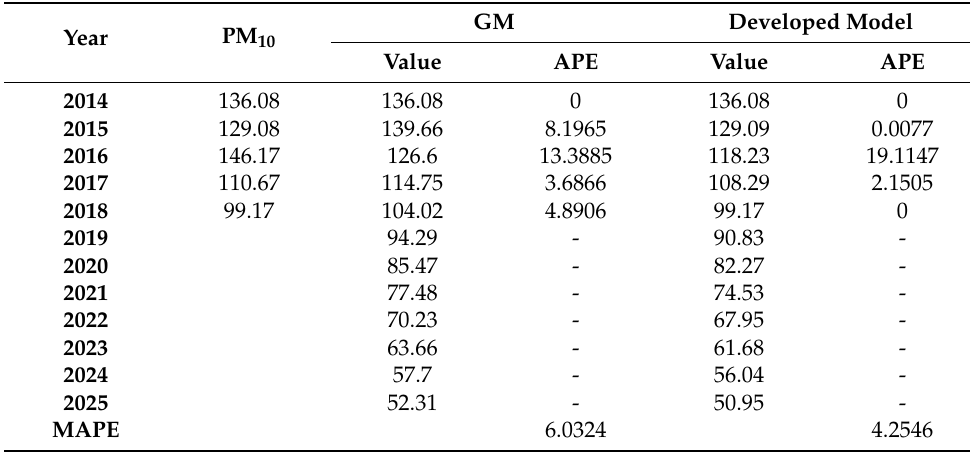
Table 4. Results of GM (1, 1) and the developed model for PM 10.